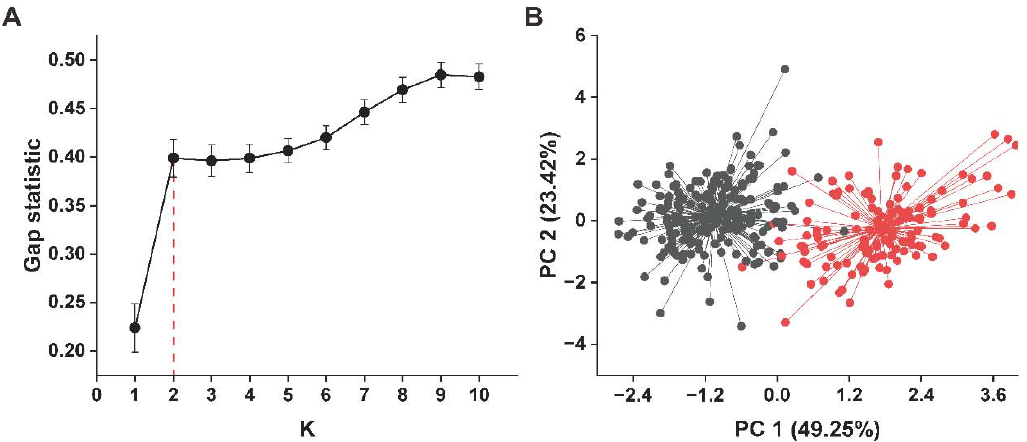
Figure 2. Cluster analysis of plant height and spike-related traits. ( A ) Gap statistic value of each cluster group. The red dashed line represents the optimal K number. ( B ) Results of K-means clustering. The grey and red represent subgroup 1 and subgroup 2, respectively. Table 4. The performance of traits in different wheat categories. Subgroup